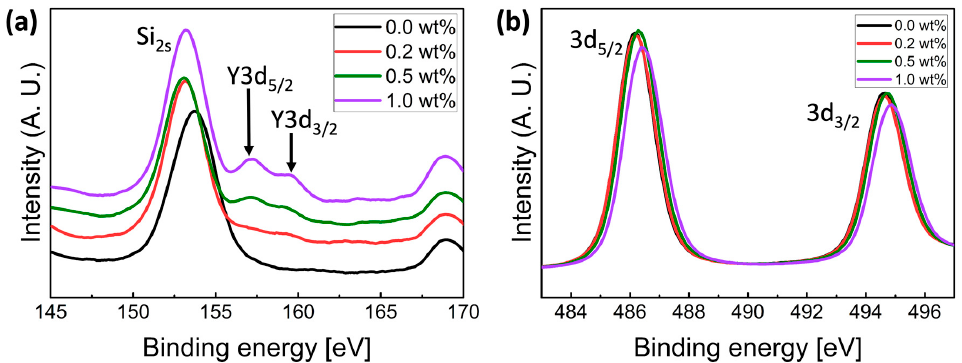
Figure 3. XPS spectra for Y-doped SnO 2 films, with different Ywt% in the ( a ) Y3d, and ( b ) Sn3d regions.